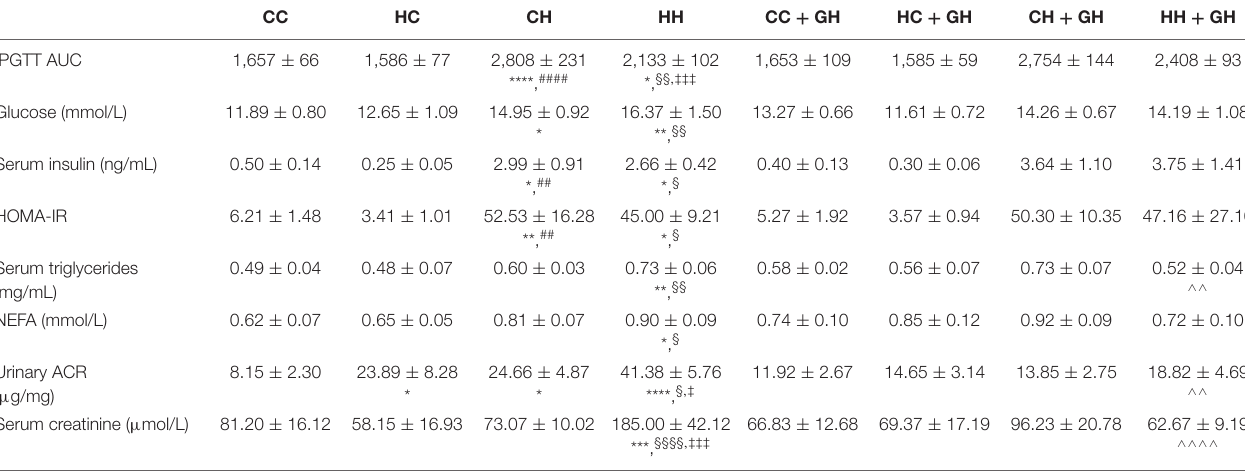
TABLE 3 | Metabolic parameters. CC HC CH